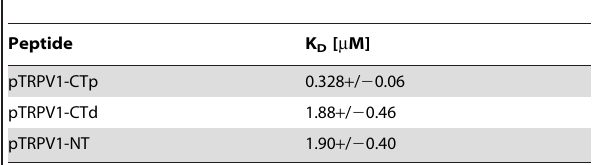
Table 2. Equilibrium dissociation constants (K D ) and their standard deviations of synthetic peptides (pTRPV1) of three different regions on the cytoplasmic tails binding to Bodipy H FL C5, C6-PtdIns(4,5)P2 estimated by fluorescence anisotropy measurement.